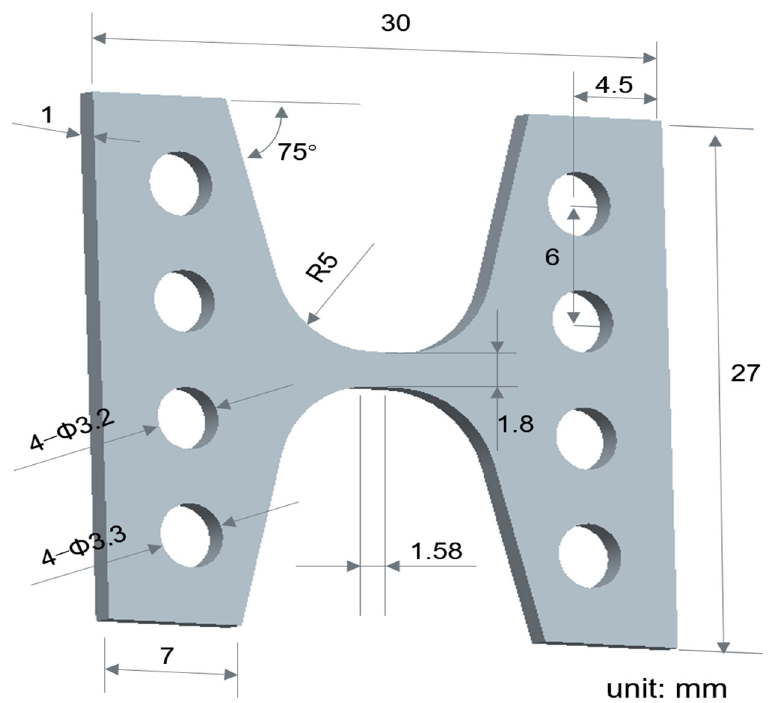
Figure 2. Geometric dimensions of specimen for in situ uniaxial tensile